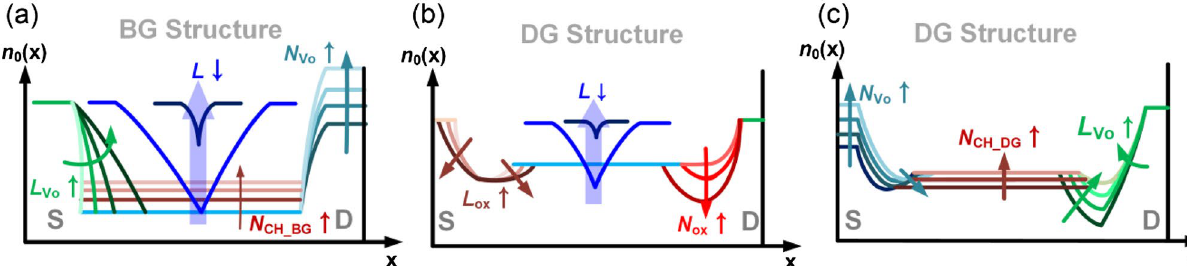
Figure 9. ( a ) Change of n 0 ( x ) by the variations of L Vo , N Vo , N CH_BG , and L in the BG structure. ( b ) Change of n 0 ( x ) by the variations of L , L OX , and N OX in the DG structure. ( c ) Change of n 0 ( x ) by the variations of N Vo , N CH_DG , and L Vo in the DG